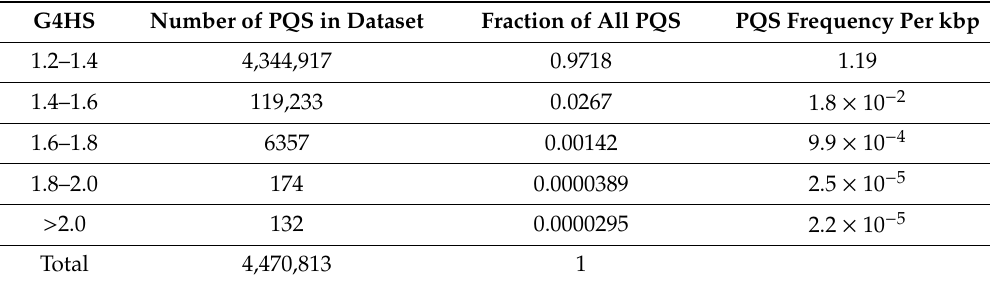
Table 2. Number of PQS found and their frequencies per 1000 bp in all 3387 archaeal genomes, grouped by G4Hunter score (1.2-1.4 means any sequence with a score between 1.2 and 1.399; 1.4 between 1.4 and 1.599,